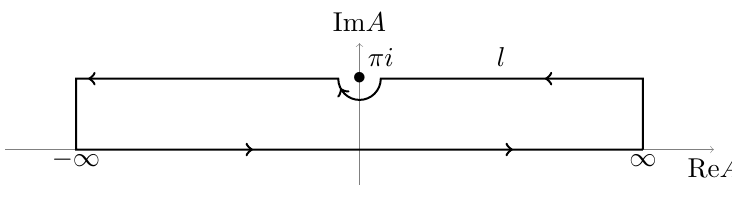
Figure 3 . A path l for (C.10). There is a simple pole at A = πi